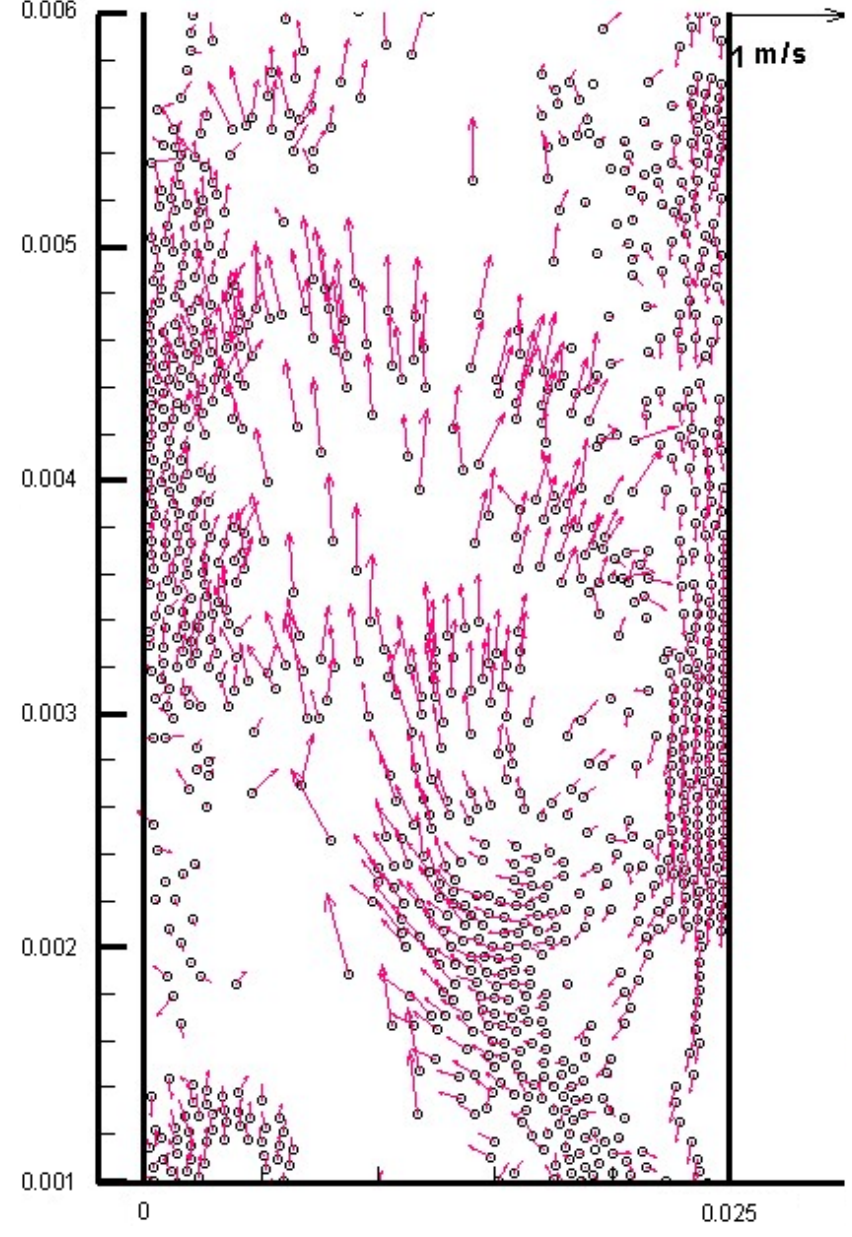
t . Figure 8. Particle locations and velocity with moderate t r = r